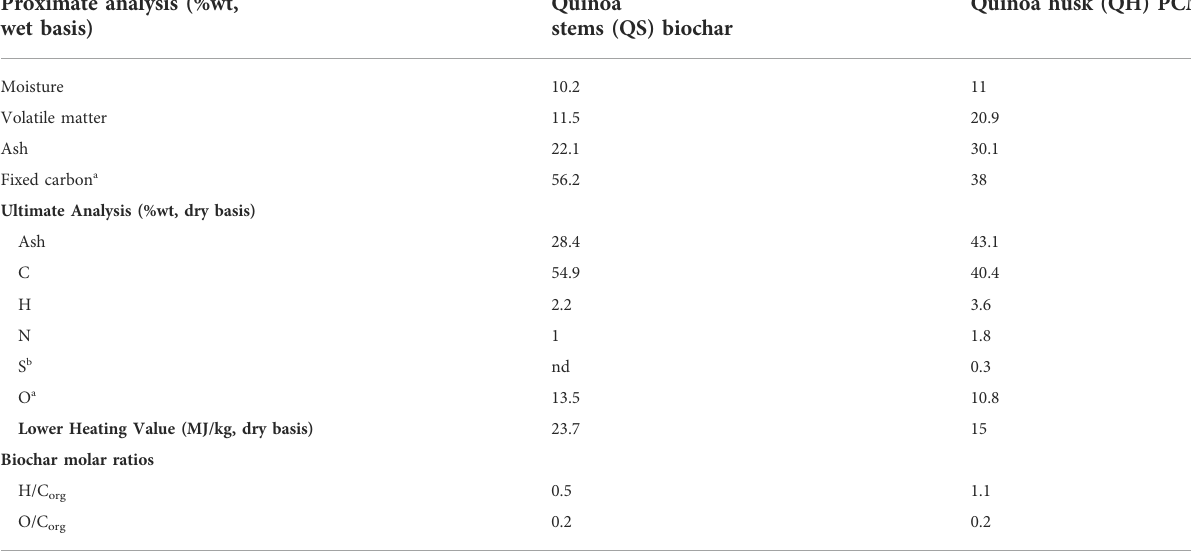
TABLE5Proximateandelementalanalysisthebiocharproducedduringthepyrolysisexperimentsofquinoastems(QS)andthePCMproducedduring the pyrolysis of quinoa husks (QH). Proximate analysis (%wt, wet